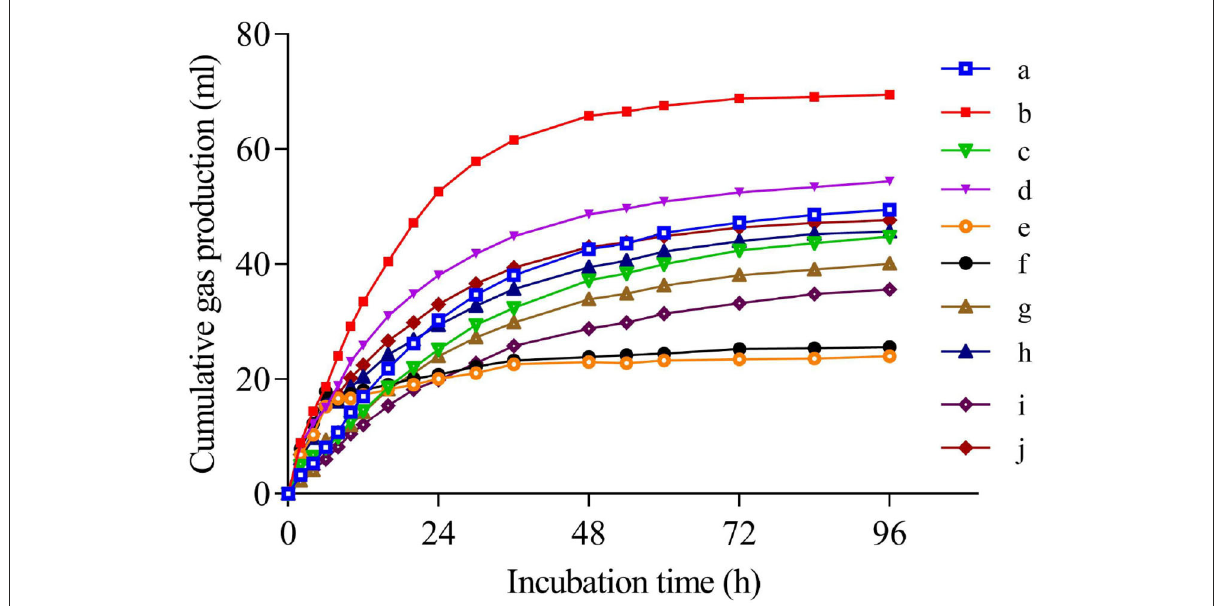
FIGURE4 In vitro gas production dynamics of feedstuff before and after steam explosion processing (a: raw corn cob; b: steam-exploded corn cob; c: raw rice straw; d: steam-exploded rice straw; e: raw peanut shell; f: steamed-exploded peanut shell; g: raw millet stalk; h: steamed-exploded millet stalk; i: raw sugarcane tip; j: steam-exploded sugarcane